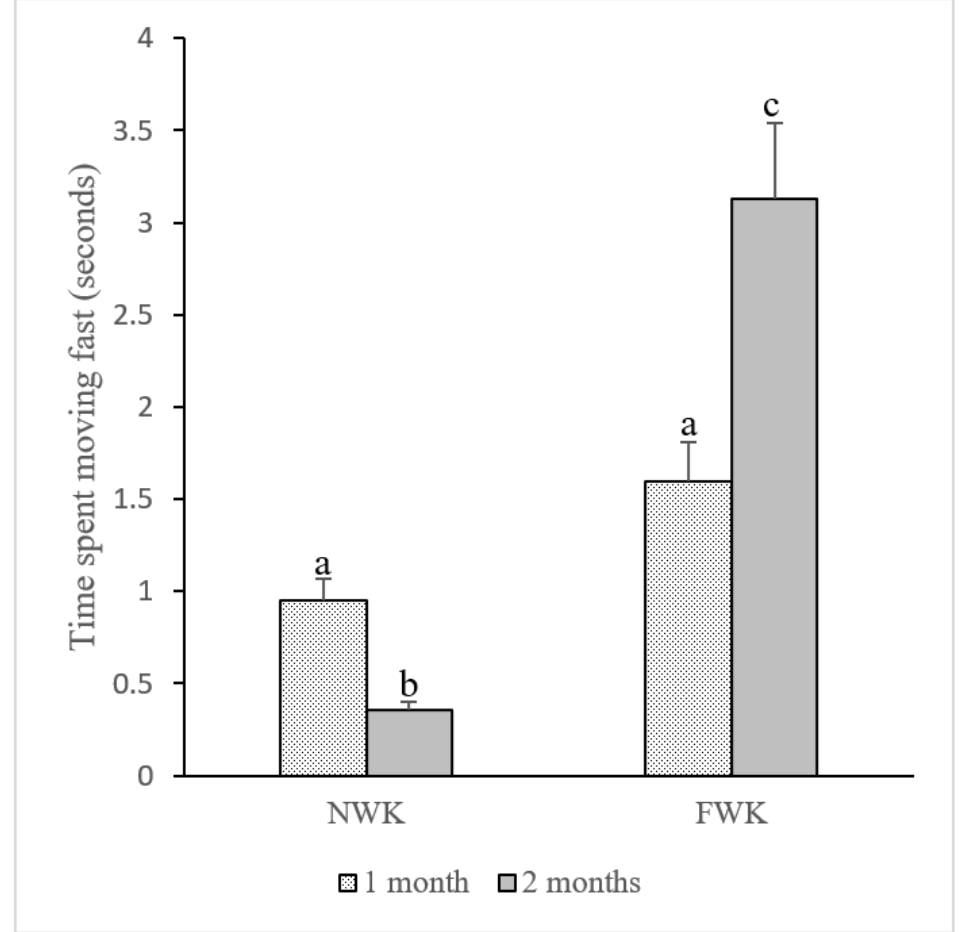
Figure 4. Time spent moving fast by the puppies. Two-month-old puppies exhibited significantly more trotting and running when the experimenter was walking at a fast pace compared to a normal pace (LME with permutation test, p = 0.000), whereas one-month-old puppies did not exhibit such a difference (LME with permutation test, p = 0.072). NWK: Normal walk, FWK: Fast walk. Graphics represent means + Standard Errors (seconds). Different letters mean significant differences.